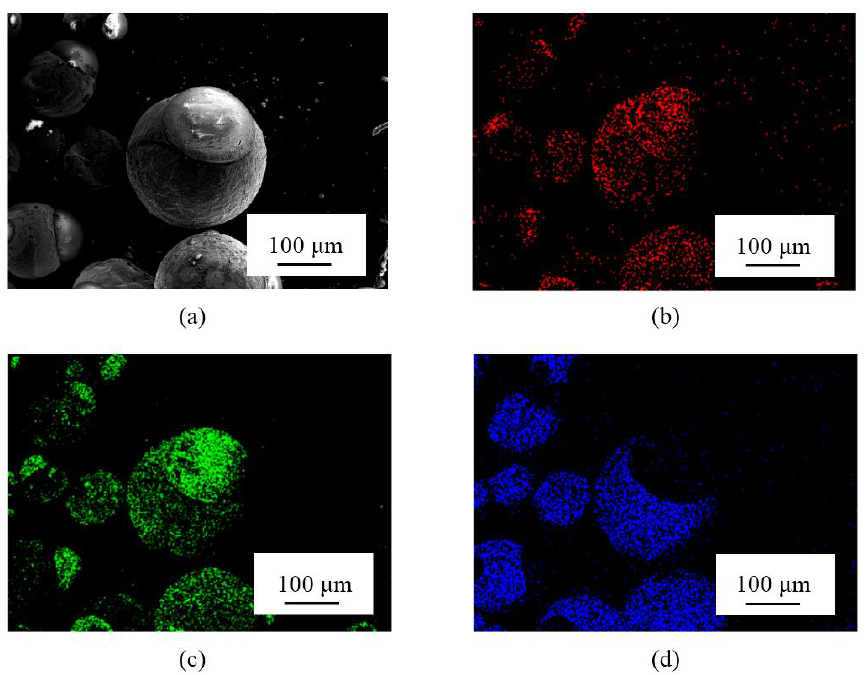
Figure 10. EDS area scan of Ni5Al sphered particles: ( a ) Original SEM photo, ( b ) Map of oxygen, ( c ) Map of aluminum, ( d ) Map of Nickel.